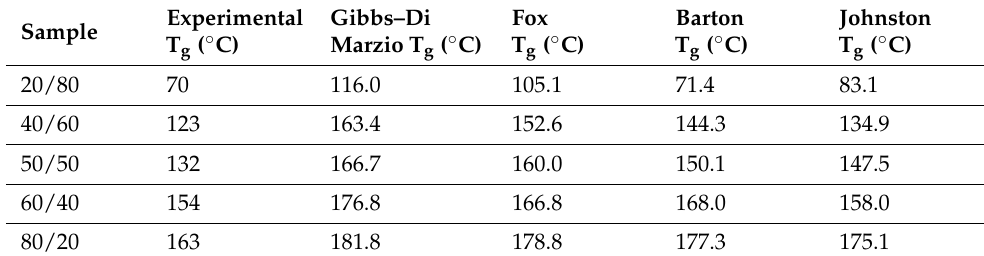
Figure 5. Plot of the linearized form of the Johnston equation.